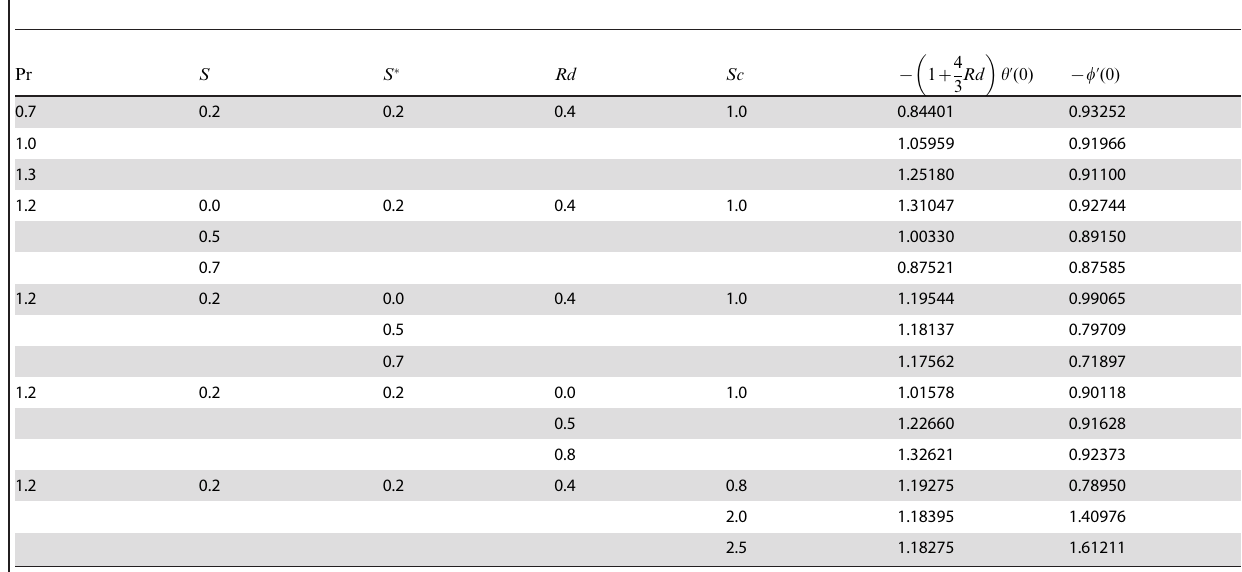
Table 5. Values of local Nusselt number { 1 z Rd and Sc when M ~ 0 : 6, b ~ 0 : 4, l 1 ~ 0 : 5 and l ~ 0 : 3 ~ N